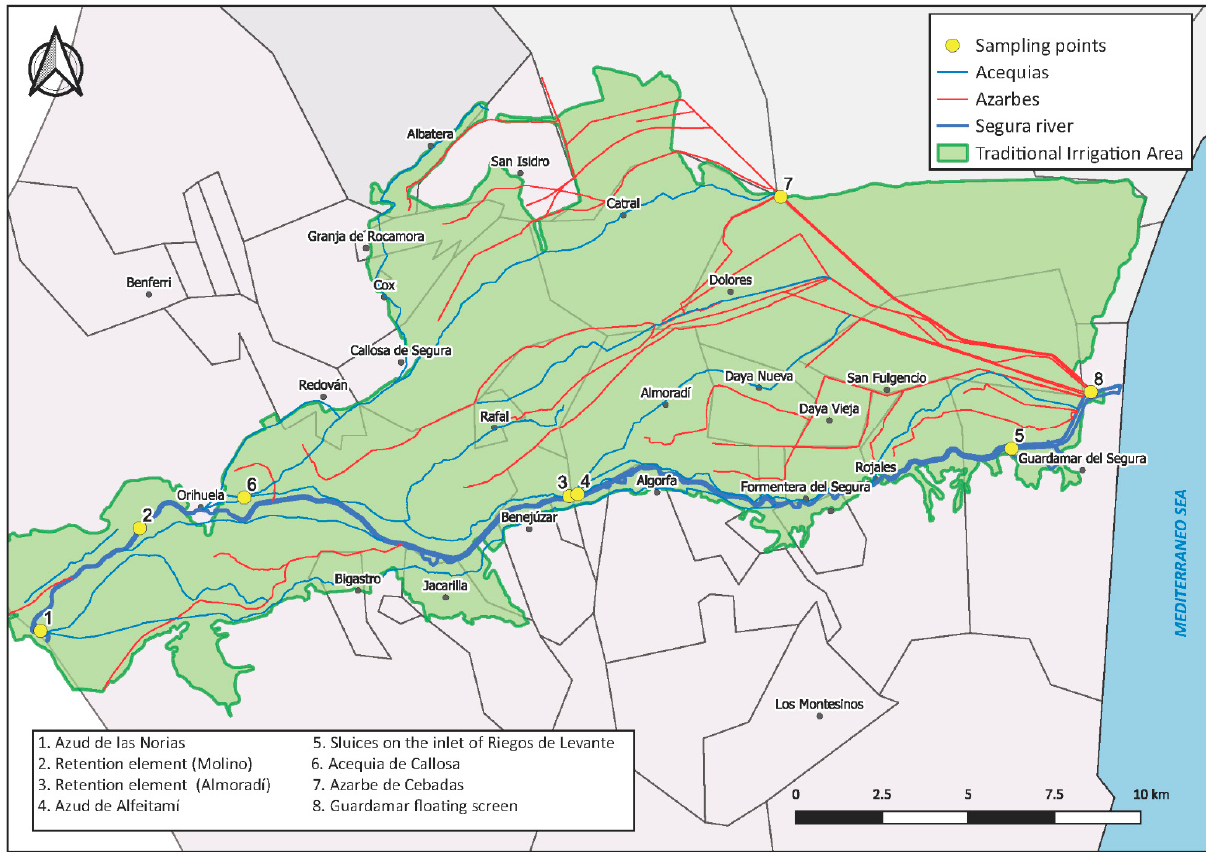
Figure 2. Traditional irrigation area along the lower course of the Segura River. The names correspond to the municipalities in the area. Yellow dots correspond to the sampling points locations as described in the text. Acequias correspond to irrigation channels while Azarbes correspond to drainage ditches.